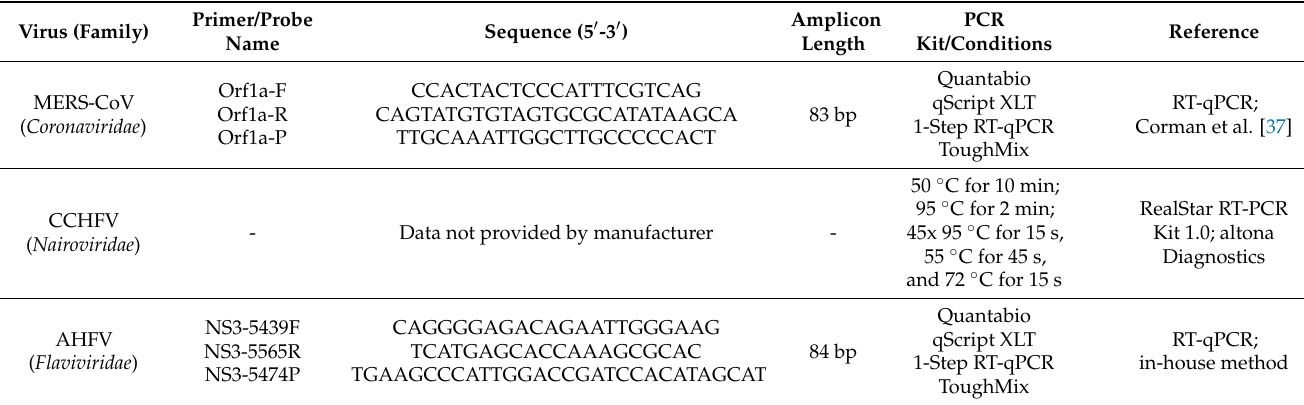
Table 1. PCR conditions, primers, and probes that were used for the detection of